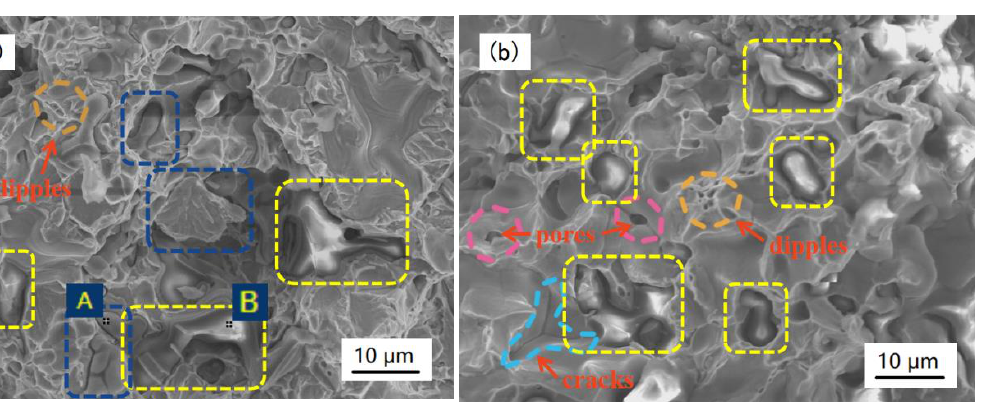
Figure 5. Morphology and EDS analysis results of SiC in the (Ti 3 AlC 2 + SiC)/Fe composites: ( a ) micrograph, ( b ) EDS results of spectrum 1, ( c ) Si, and ( d ) Fe.